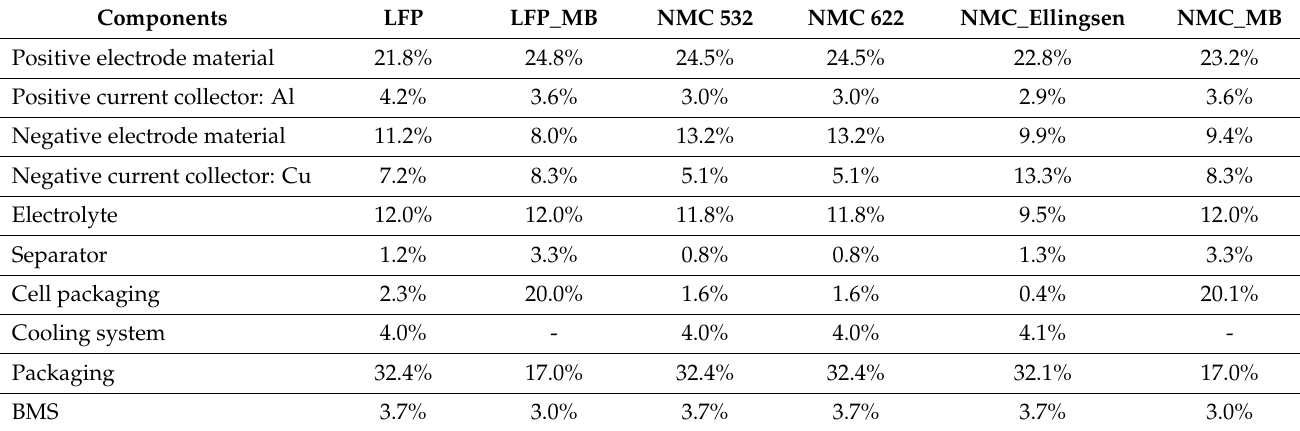
Table 8. Mass composition of the different batteries’ components (Majeau-Bettez (MB) [21]; Ellingsen et al. [3].